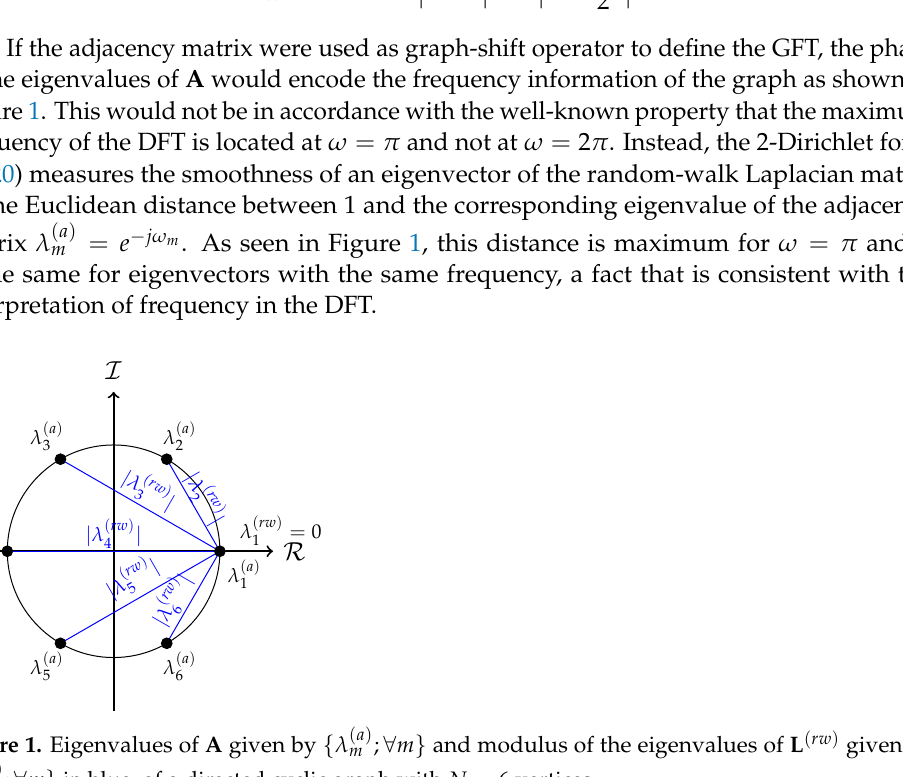
Figure 1. Eigenvalues of A given by { λ { λ ( a ) ∀ m } in blue, of a directed cyclic graph with N = 6 m ;